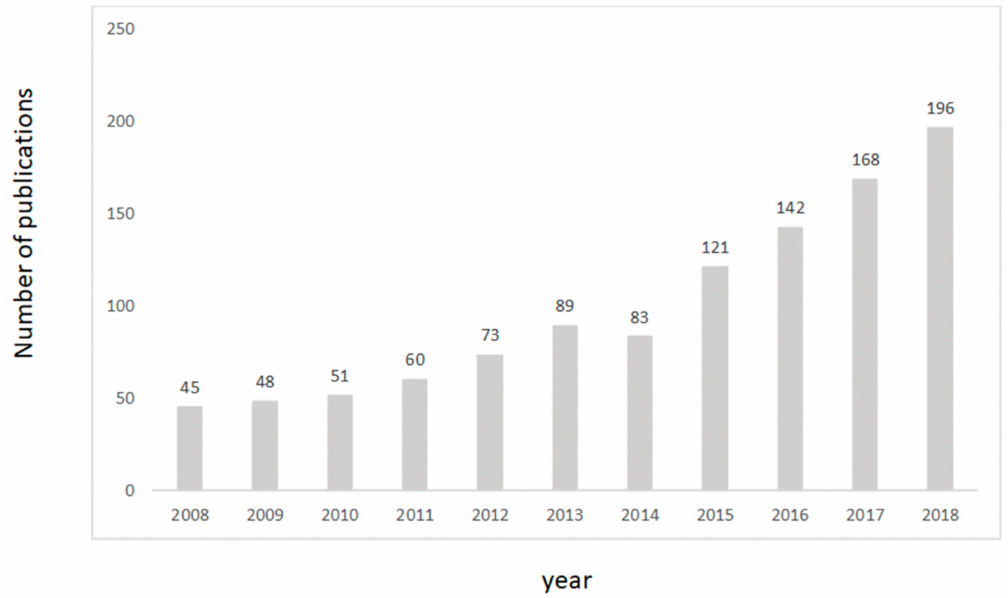
Figure 2. Number of citations including the words chemometric, multivariate data analysis, and food (source Web of